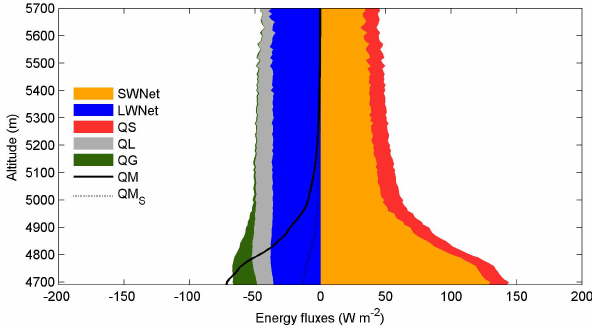
Fig. 11. Time series of energy balance terms as mean values over the whole study period (September 2006–August 2008) vs. altitude. QM S is the melt energy in the